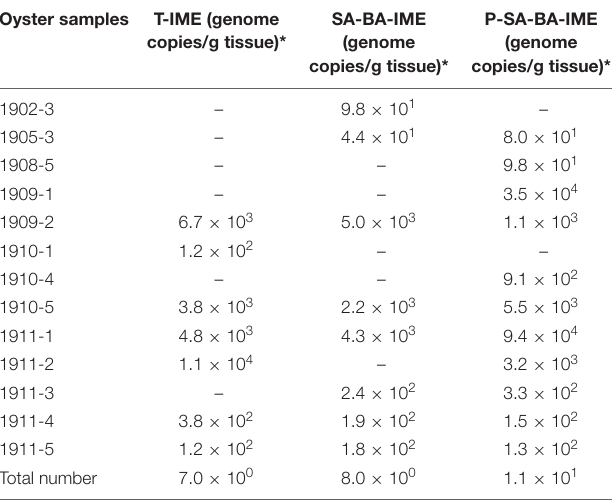
TABLE 1 | NoVs-positive oysters detected by three novel